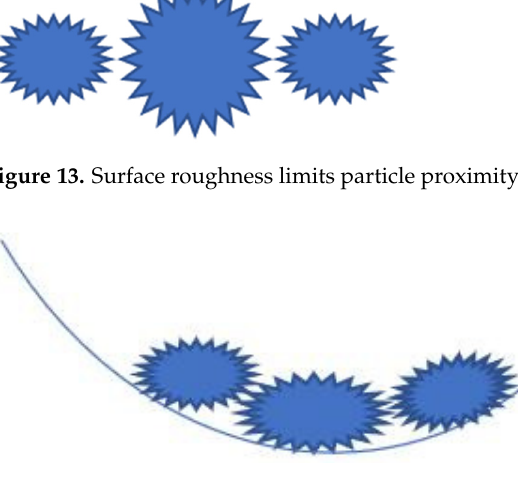
Figure 14. Surface structure enhances tight contact.